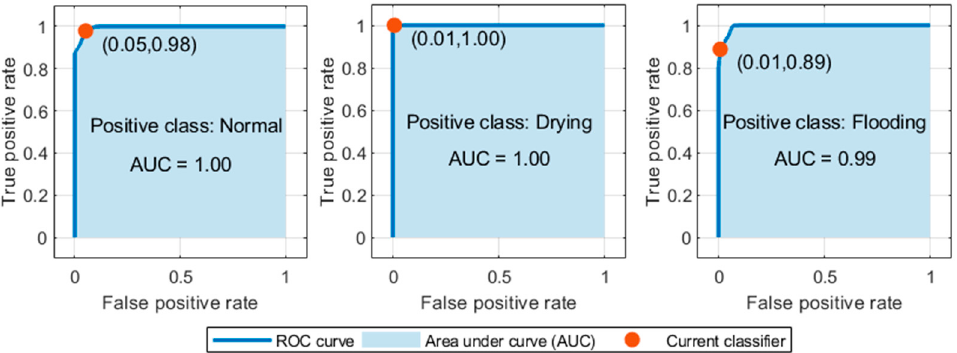
Figure 12. Receiver operating characteristics for SVM classifier training process.